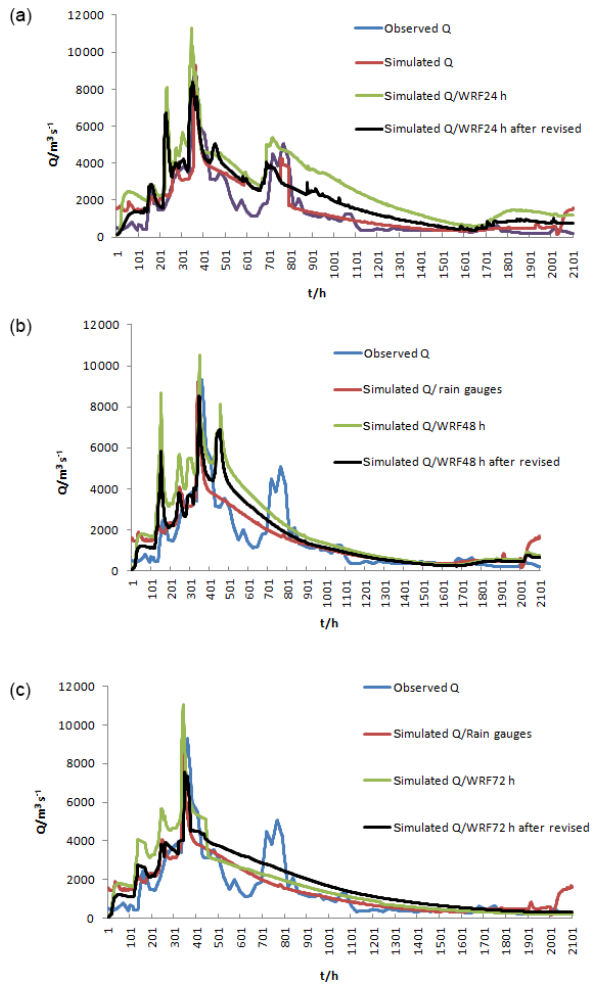
Figure 7. Coupled flood simulation results with the original model parameters (2011). (a) is the simulated result with 24h lead time, (b) is the simulated result with 48h lead time, and (c) is the simu- lated result with 48h lead time. Figure 8. Coupled flood simulation results with the original model